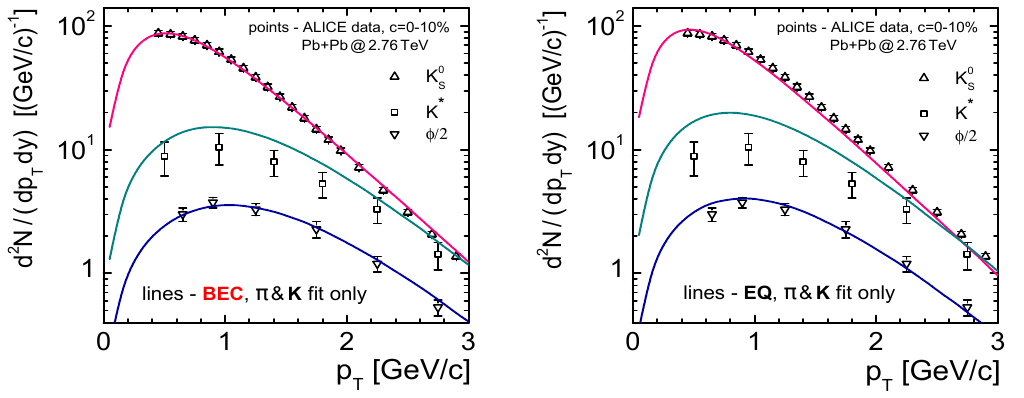
Figure 4. Strange mesons obtained for the hypersurface, which was fitted to pions and kaons only. Figure 2. The fit of pions and kaons, and the prediction for protons, ρ and η in 0-10% centrality window.